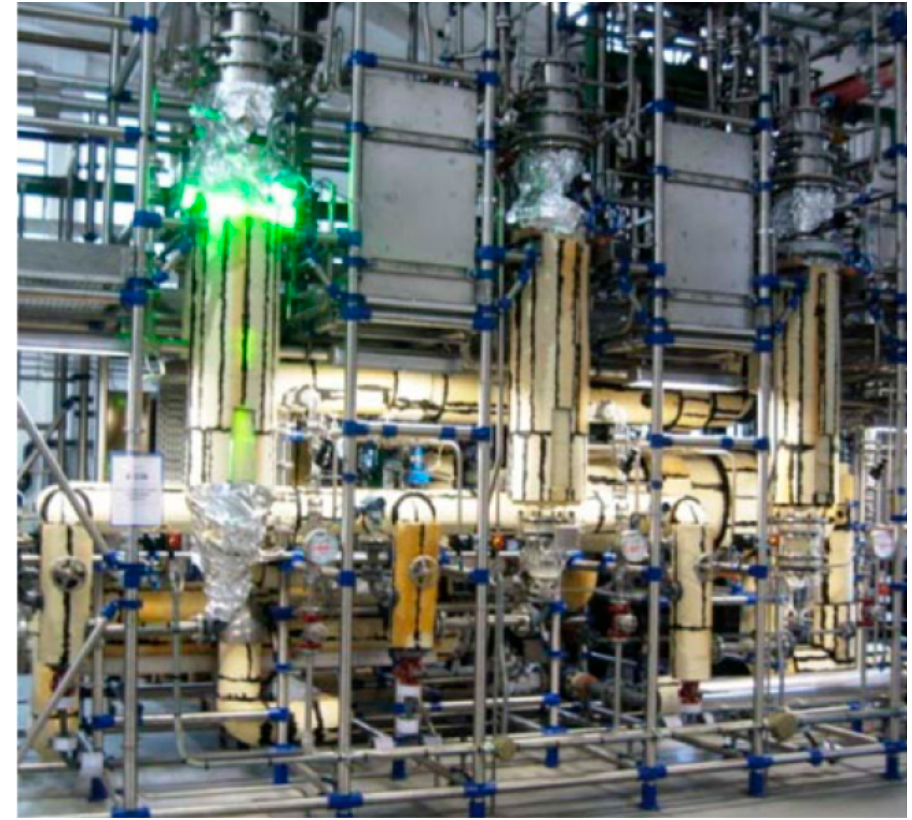
Figure 2. Photooxidation process in semi-synthetic artemisinin ( 1 ) production by Sanofi (Reprinted with permission from [58] Copyright 2016 American Chemical Society).